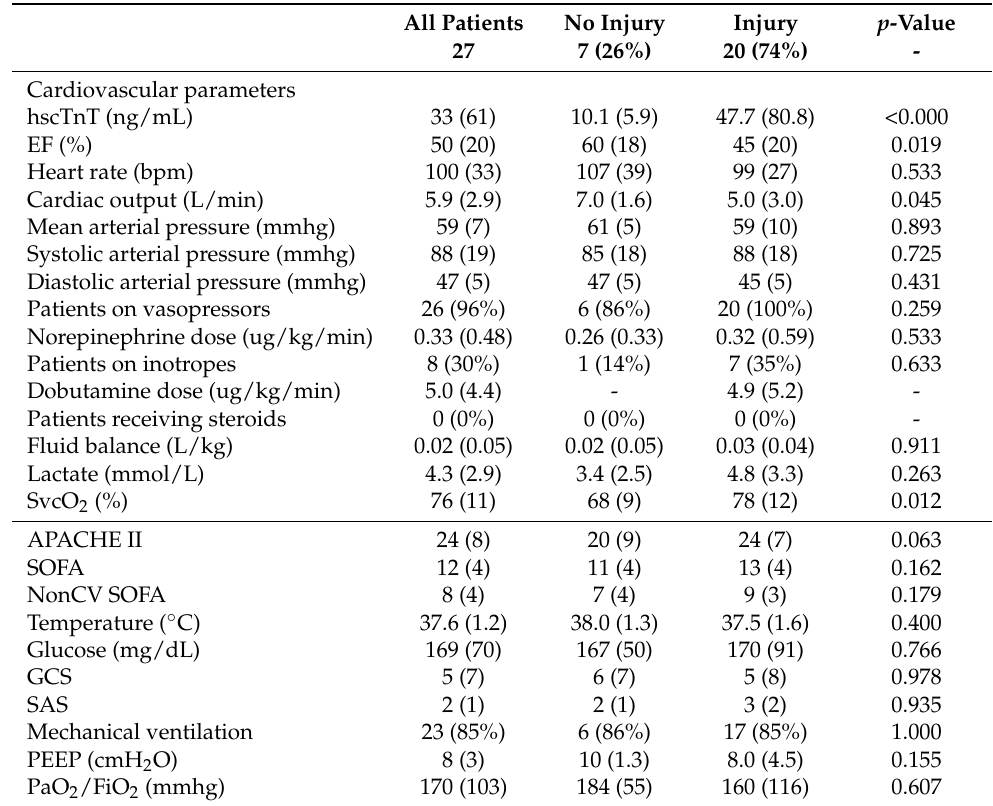
Table 2. Patient characteristics at ICU admission. Part II. Data are presented as median (interquartile range) or number (percentage). NonCV SOFA was calculated by subtracting the points of cardiovascu- lar (CV) dysfunction to the total SOFA score. AKI—acute kidney injury according to “kidney disease: improving global outcomes” classification; APACHE II—acute physiology and chronic health evalua- tion II score; bpm—beats per minute; GCS—Glasgow coma scale; fluid balance—from the last 24 h; hscTnT—high sensitive cardiac troponin T; INR—international normalised ratio; PEEP—positive end-expiratory pressure; SAS—sedation-agitation scale; SOFA sequential organ failure assessment score; SvcO 2 —central venous oxygen